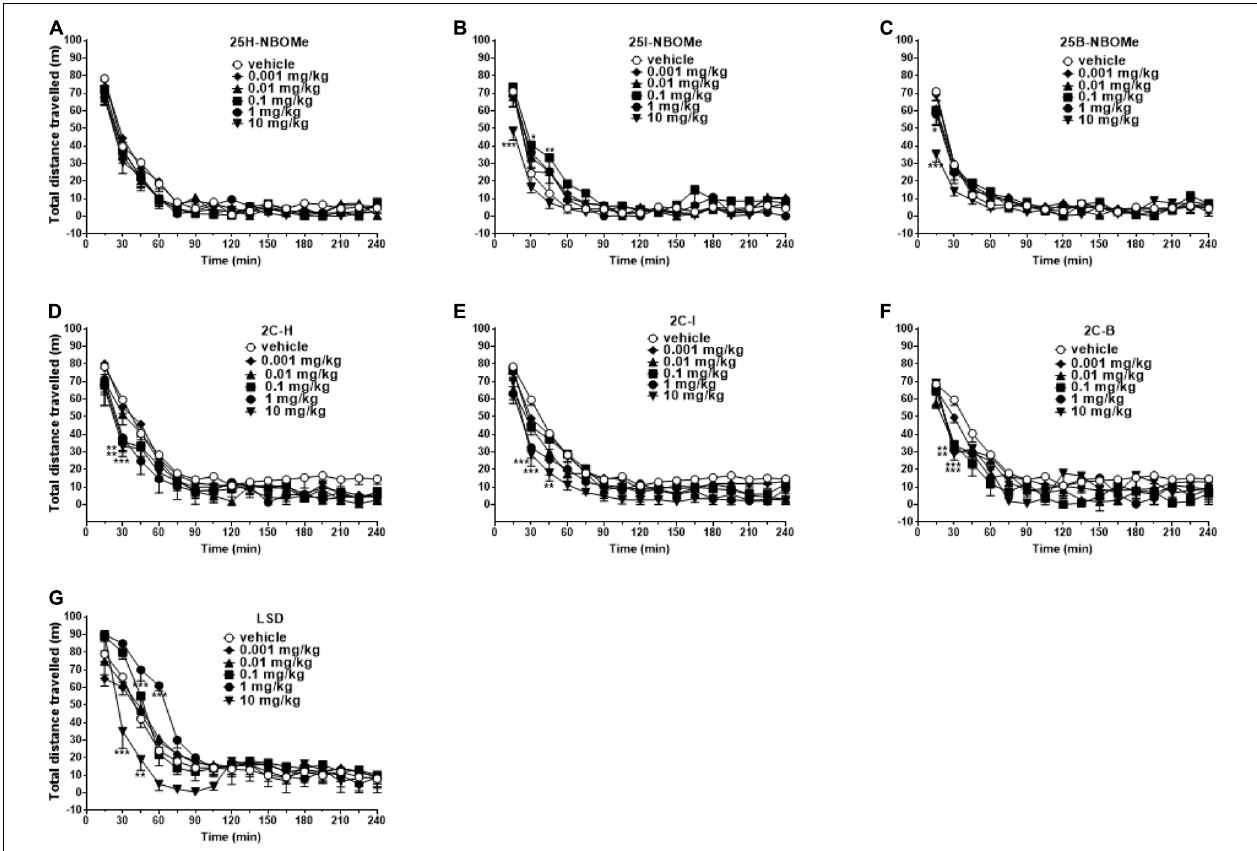
FIGURE 7 | Effect of 25H-NBOMe (0.001–10 mg/kg i.p.) (A) , 25I-NBOMe (0.001–10 mg/kg i.p.) (B) , 25B-NBOMe (0.001–10 mg/kg i.p.) (C) , 2C-H (0.001–10 mg/kg i.p.) (D) , 2C-I (0.001–10 mg/kg i.p.) (E) , 2C-B (0.001–10 mg/kg i.p.) (F) , and LSD (0.001–10 mg/kg i.p.) (G) on the total distance traveled of mice over a 4-h observation period. Data are expressed as meters traveled and represent the mean ± SEM of eight determinations for each treatment. Statistical analysis was performed by two-way ANOVA followed by Bonferroni’s test for multiple comparisons for the dose–response curve of each compound at different times. * p < 0.05, ** p < 0.01, *** p < 0.001 vs. vehicle.